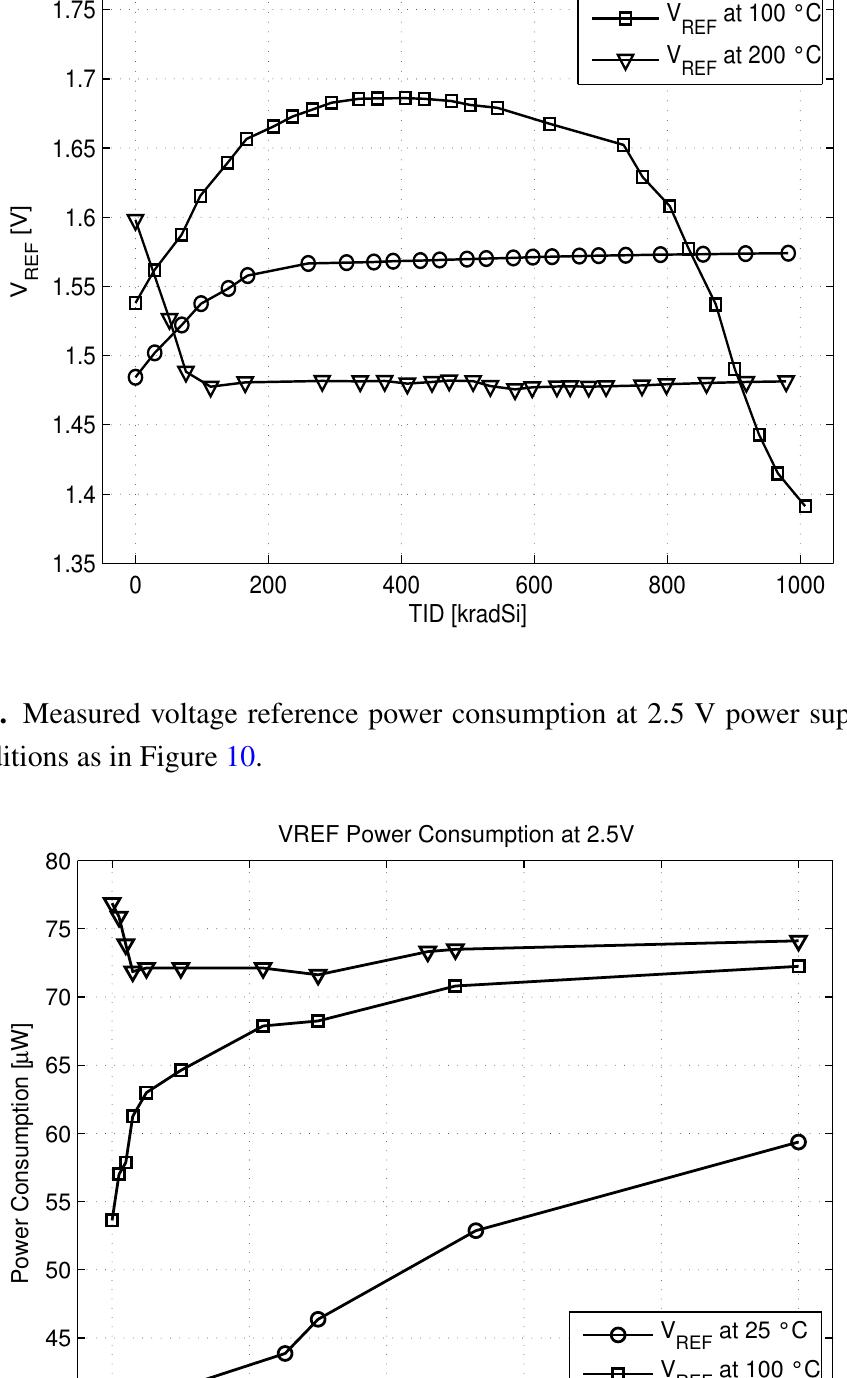
Figure 10. Measured voltage reference V